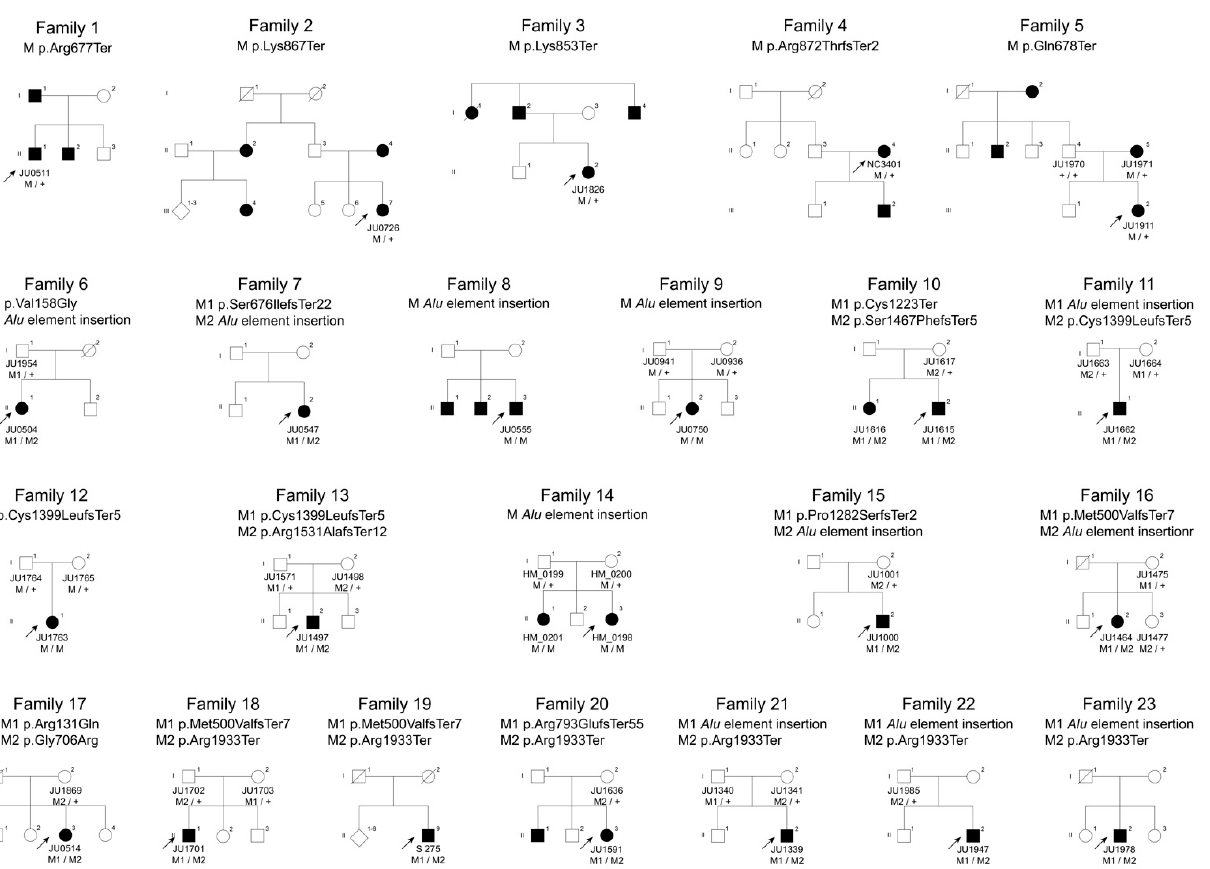
Figure 1. Pedigrees of the 23 Japanese families with RP1 -associated retinal dystrophies. Five families (Families 1 to 5) with autosomal dominant retinitis pigmentosa (RP), 11 families (Families 6 to 16) with autosomal recessive RP and 7 families (Families 17 to 23) with autosomal recessive cone dystrophy/cone-rod dystrophy. Square boxes and circles indicate males and females, respectively. Filled symbols represent affected members, whereas unfilled symbols represent unaffected members. The plus sign denotes the wild-type allele, and the arrow indicates the proband of the